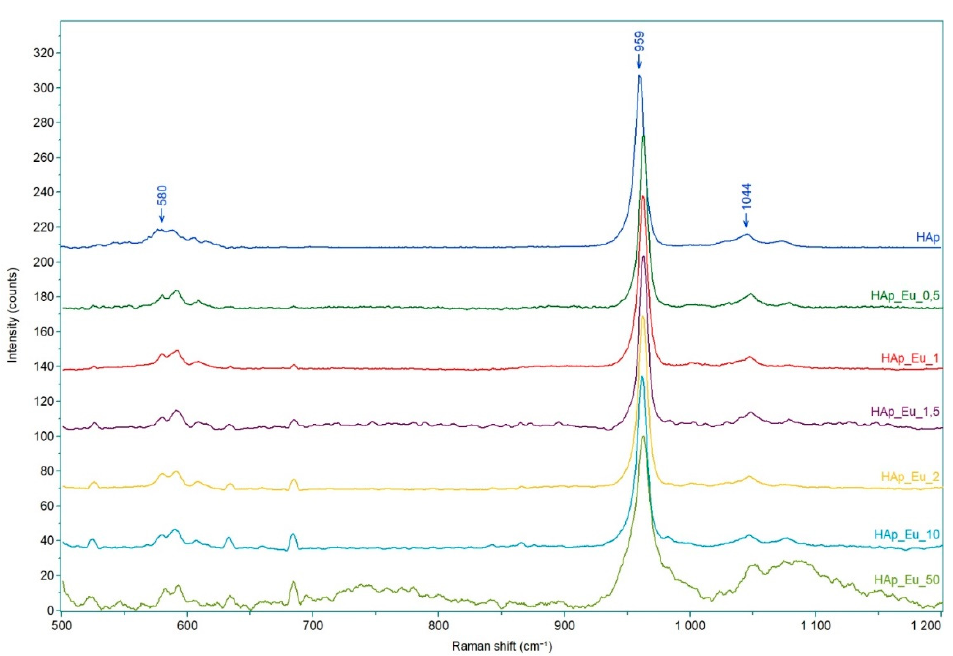
Figure 7. Raman spectra of Eu X HAp samples.